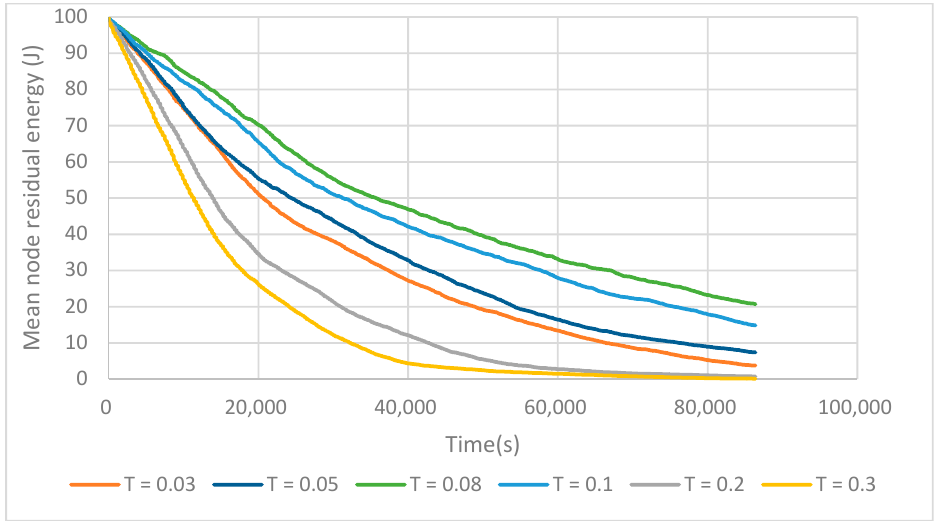
Figure 10. T value impact on network lifetime. Sensors 2017 , 17 , 2706